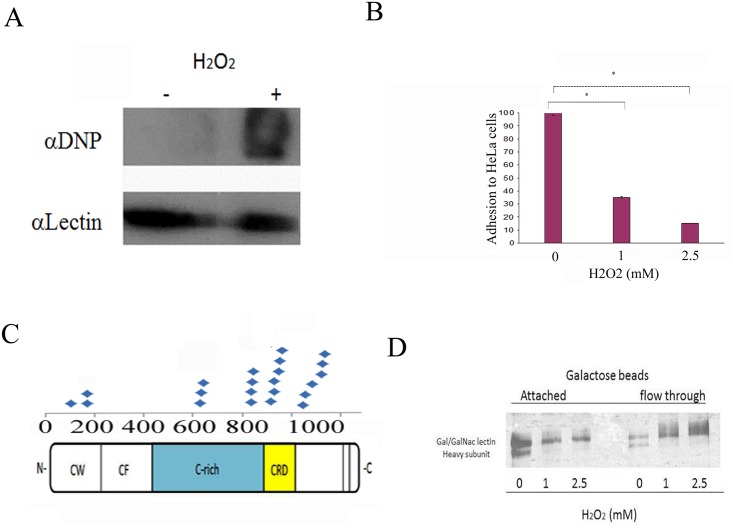
H2O2 inhibits the adhesion of E. histolytica to HeLa cells.A. Confirmation of OX-RAC data about the oxidation of the Hgl by using the OxyBlot protein oxidation detection kit. This figure displays a representative result from two independent experiments. B. E. histolytica trophozoites strain HM-1:IMSS were grown in Diamond’s TYI-S-33 medium and exposed to H2O2 for 20 minutes before their incubation with a fixed HeLa cell monolayer for 30 minutes at 37°C. Data are expressed as the mean ± standard deviation of three independent experiments that were performed in triplicate. The adhesion of the H2O2-treated trophozoites was significantly different (p<0.05) from the control (100%) according to the results of an unpaired Student’s t-test in which statistical significance was set at 5%. C. Repartition of the carbamidomethylated cysteine residues in the Hgl as an indication of their oxidation status. These residues were mostly located in the cysteine-rich region (C-rich) in the carbohydrate recognition domain (CRD) and in the cysteine-tryptophan domain (CW) and were absent in the cysteine-free domain (CF). D. Dose-dependent inhibition of Gal/GalNAc lectin binding to D-galactose-coated agarose beads by H2O2. Gal/GalNAc lectin was purified by D-galactose affinity chromatography and incubated with different concentrations of H2O2 for 10 minutes at 37°C. The binding to galactose-coated agarose beads was determined by SDS-PAGE gel electrophoresis and silver staining. This figure displays a representative result from two independent experiments.